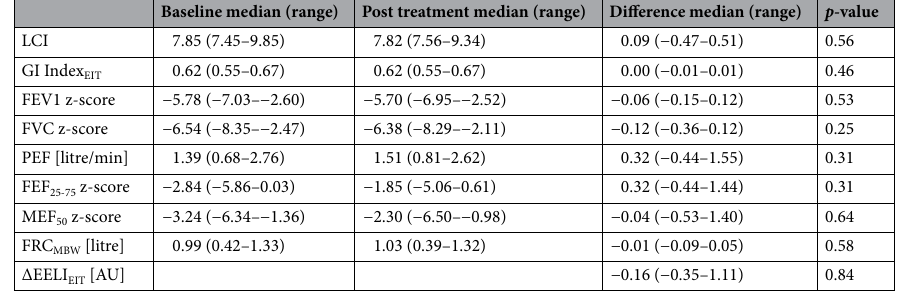
Table 2. Lung function tests before and after insufflation/exsufflation session results presented as median (range); p -value derived from Wilcoxon’s signed ranks test. LCI: lung clearance index; GI Index EIT : global